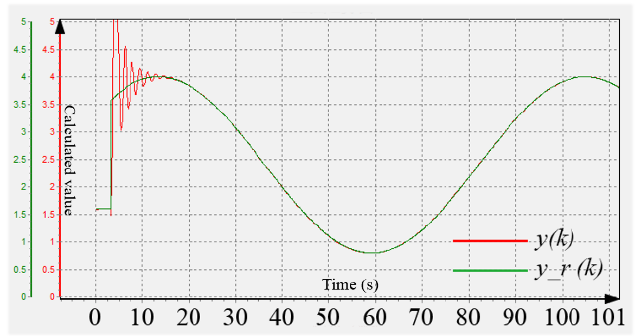
Figure 8. The estimated and real numerical simulations signals. Initial speed guess before 3 s is 1.6. Under the simulation conditions, the errors are significantly large and chattering in the early stages, but reduce fast when the weights converge and the performance approaches approximately optimal values. It is shown that the control system of DRNN based on DE technology has a good self-regulation and adaptive ability that can quickly recover to a stable state and the anti-interference ability is